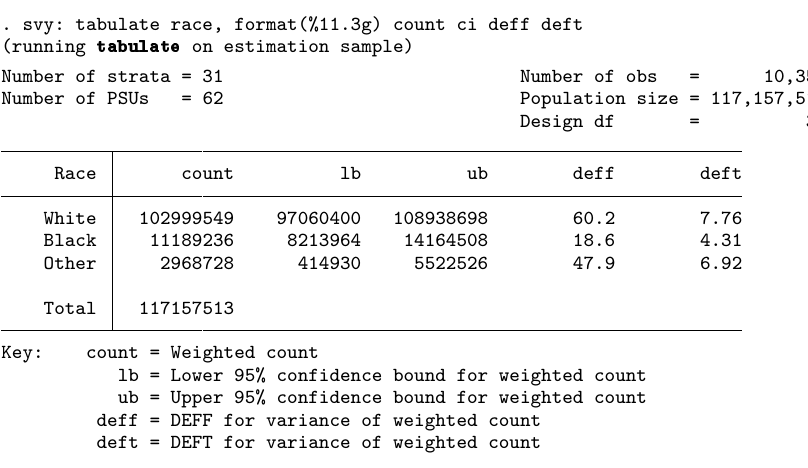
svy: tabulate oneway — One-way tables for survey data